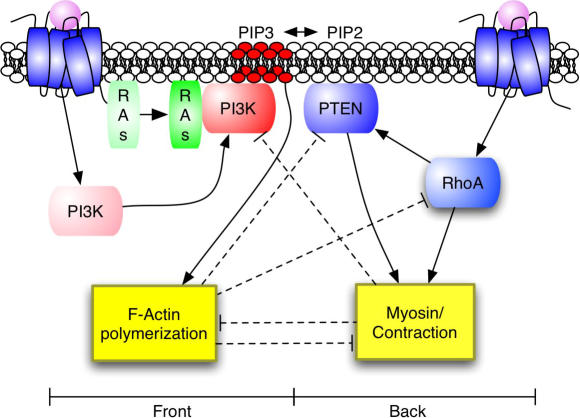
Proposed Pathway for Neutrophil ChemotaxisChemoattractant-bound G protein–coupled receptors activate both the “front” and “back” pathways. The “front” pathway activates F-actin polymerization and the “back” pathway activates myosin contractions. The two pathways cross-inhibit each other at five junctions (four are denoted by the dashed lines and the other results from the antagonizing action of PI3K and PTEN).